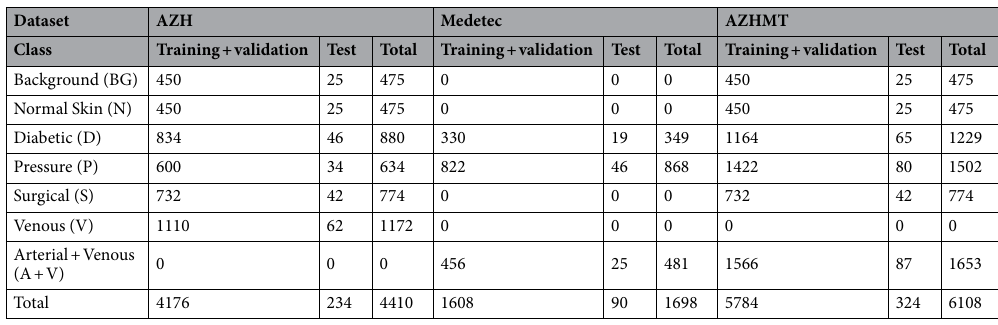
Table 2. Description of all datasets.